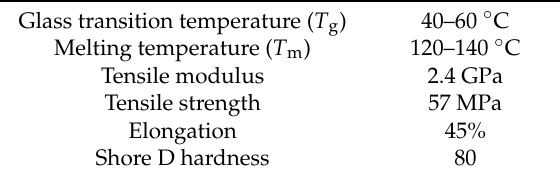
Table 3. Representative properties of the reclaimed epoxy-thermoplastic from recyclable epoxy